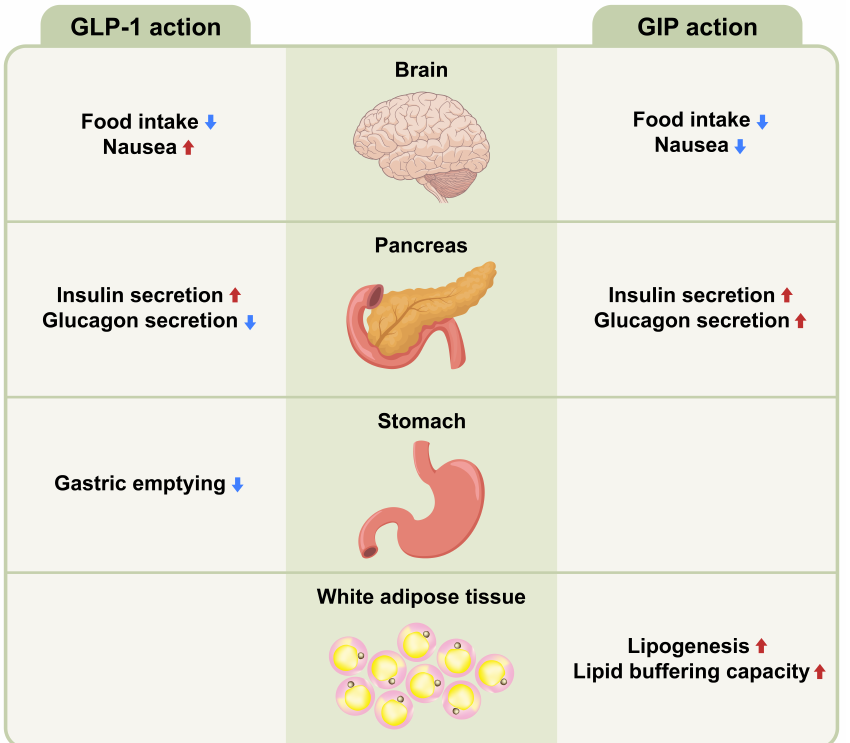
Figure 2. Metabolic action of GLP-1 and GIP on different tissues. Glucagon-like peptide-1 (GLP-1) Figure 2. Figure 2. and glucose-dependent insulinotropic polypeptide (GIP) share a function as incretins and have different pancreatic and extrapancreatic functions. GIP acts directly on the endocrine pancreas, brain and white adipose tissues, while GLP-1 acts directly on the endocrine pancreas, brain, and gastrointestinal tract. Up arrow ( ↑ ) symbol indicates increase, whereas down ( ↓ ) arrow symbol indicates decrease in the effect